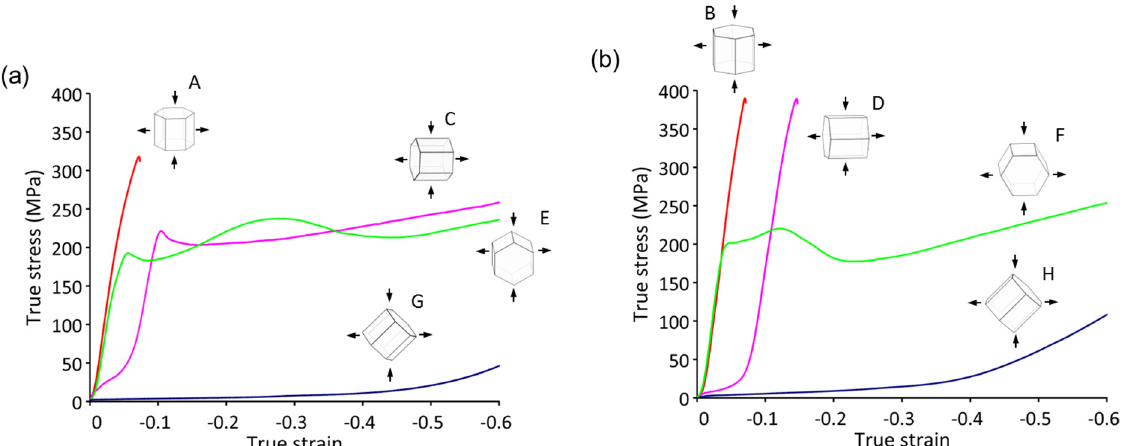
Figure 3. Flow curves of the investigated pure Mg single crystal specimens of various orientations deformed by PSC at ambient temperature and a constant strain rate of 10 − 3 s − 1 . Oil was used for lubrication. The same colors are used to denote orientations that share a 30° rotation around their respective c ‐ axis in ( a , b ).